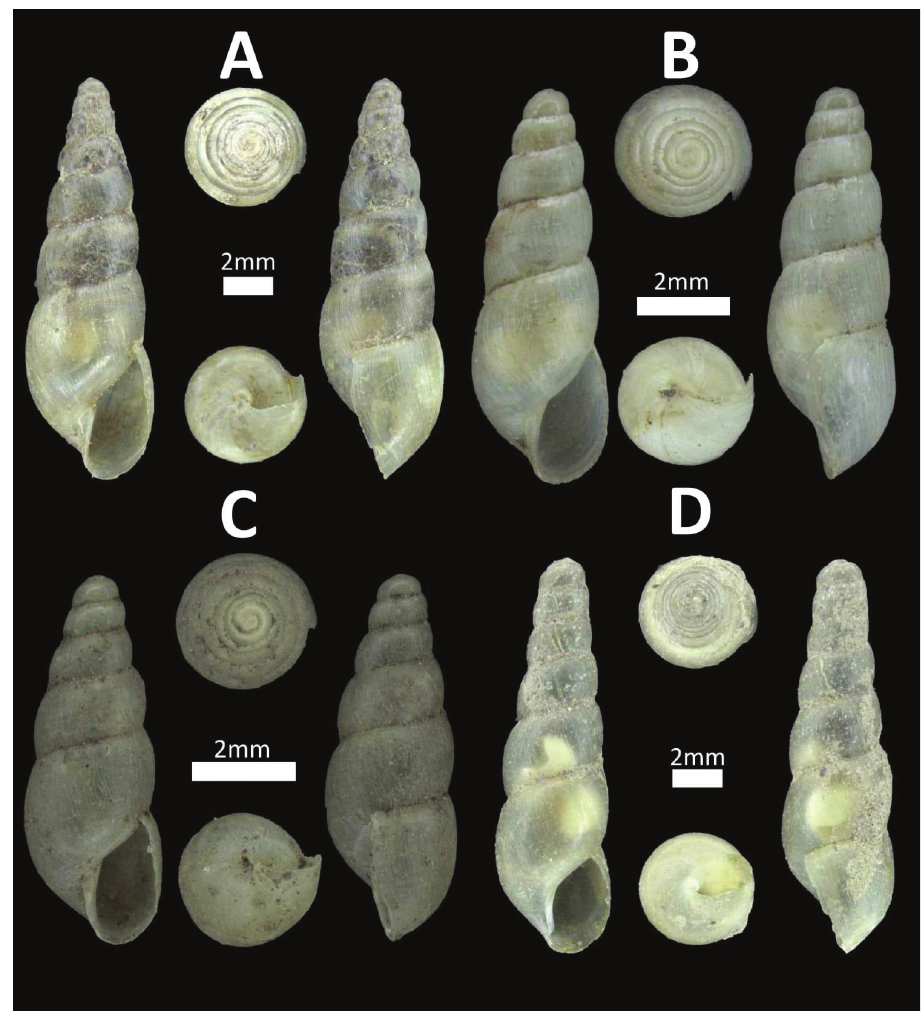
Figure 20. Family Subulinidae. A Paropeas achatinaceum (BOR/MOL 12518) B Allopeas gracile (BOR/ MOL 12058) *Juvenile C Allopeas clavulinum (BOR/MOL 12539) D Subulina octona (BOR/MOL